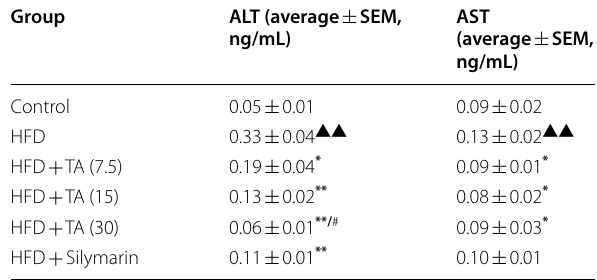
ALT and AST were measured in ng/mL. Control: mice were fed a normal diet and treated with 0.5%CMC-Na (solvent) via gavage; HFD: mice were fed HFD; HFD TA (7.5), HFD TA (15), and HFD TA (30) mice were fed HFD and treated + + + with TA (7.5, 15, and 30 mg/kg, respectively) via gavage; HFD Silymarin: mice + were fed HFD and treated with silymarin via gavage. ▲▲ P < 0.01 vs. Control; */** P < 0.05/0.01 vs. HFD group. # P < 0.05 vs. HFD Silymarin +